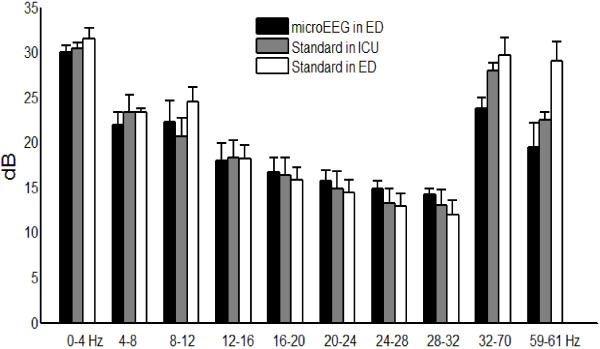
Band power for the microEEG and standard system. microEEG with Electro-Cap in the ED (28 recordings), standard system in the ICU (11 recordings), and standard system in the ED (7 recordings). Error bars indicate the standard deviation of variability due to differences among channels and recordings. Filters 0.5-70 Hz bandpass.